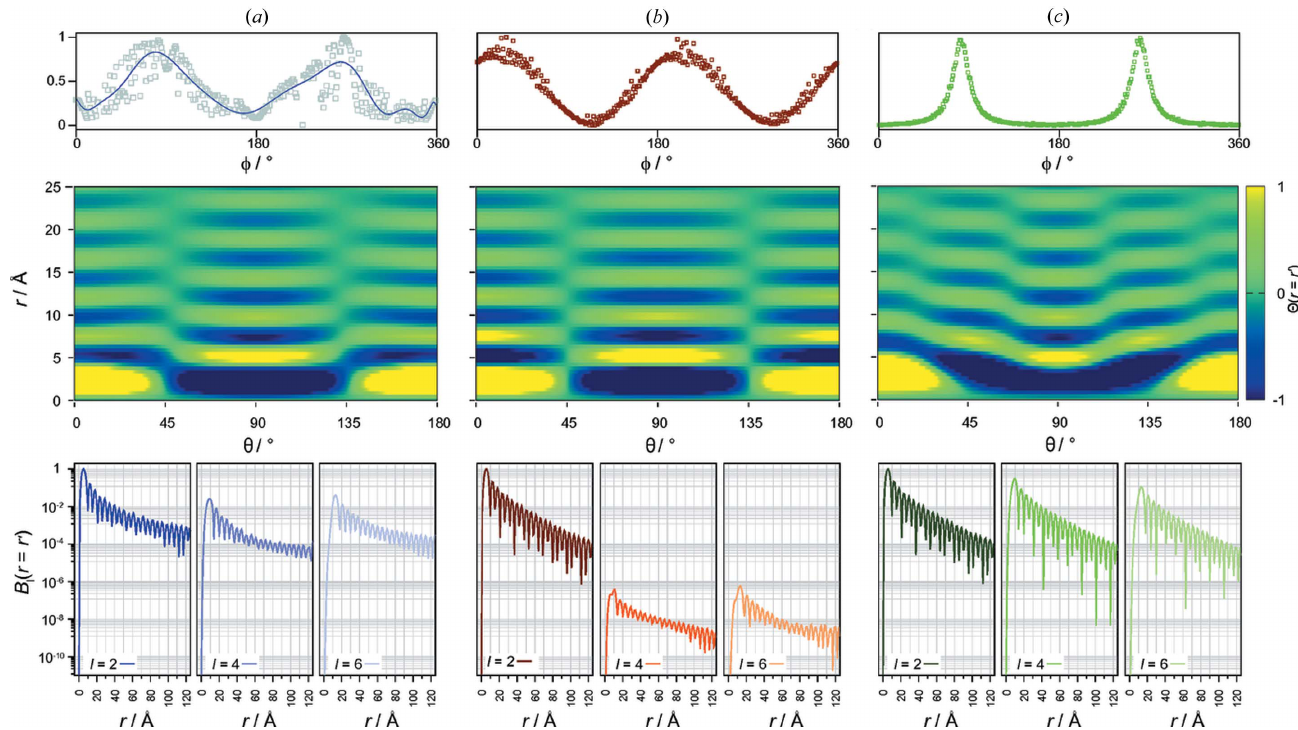
Figure 4 Comparison of pole-distribution effects on real-space spherical harmonic coefficients h B (cid:7) distribution function (top), resulting (cid:5) ( r = r 0 ) slice (middle) and spherical harmonic coefficients (bottom). The experimental distribution most closely resembles the sinusoidal modulation in ( b ). The more peaked Lorentzian modulation ( c ) produces distinct features clearly shown in both the PADF slices (middle) and the magnitudes of the spherical harmonic coefficients